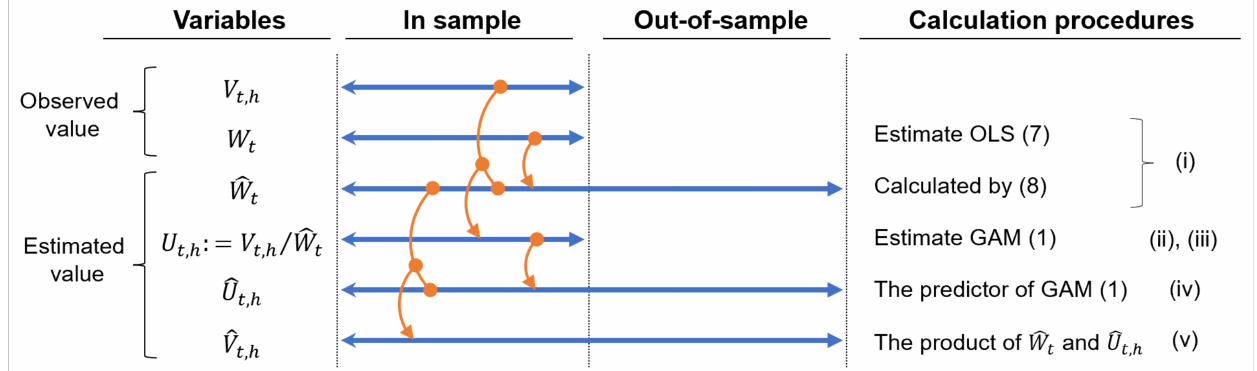
Figure 1. Estimation procedures and data periods in the area-wide PV power generation forecasting model. Note: In our empirical analysis, we use the in-sample period from 1 April 2016, to 31 December 2017, and the out-of-sample period from 1 January to 31 December 2018 (as described in Section 4.1). When using the ML methods introduced in Section 3, the only difference is that each ML model is adopted instead of GAM (1) in steps (iii) and (iv), and the other steps are the